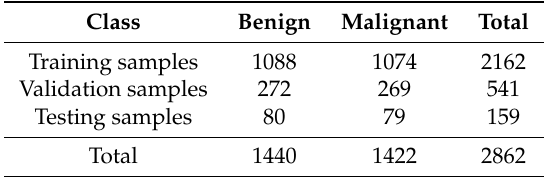
Table 4. BCDR dataset distribution after the four augmentation methods